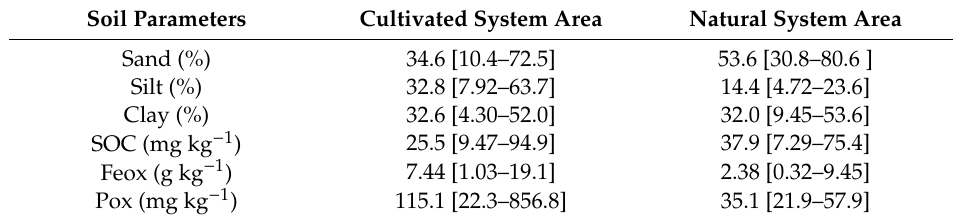
Table 2. Soil parameters description of the study sites. The values in parentheses show the